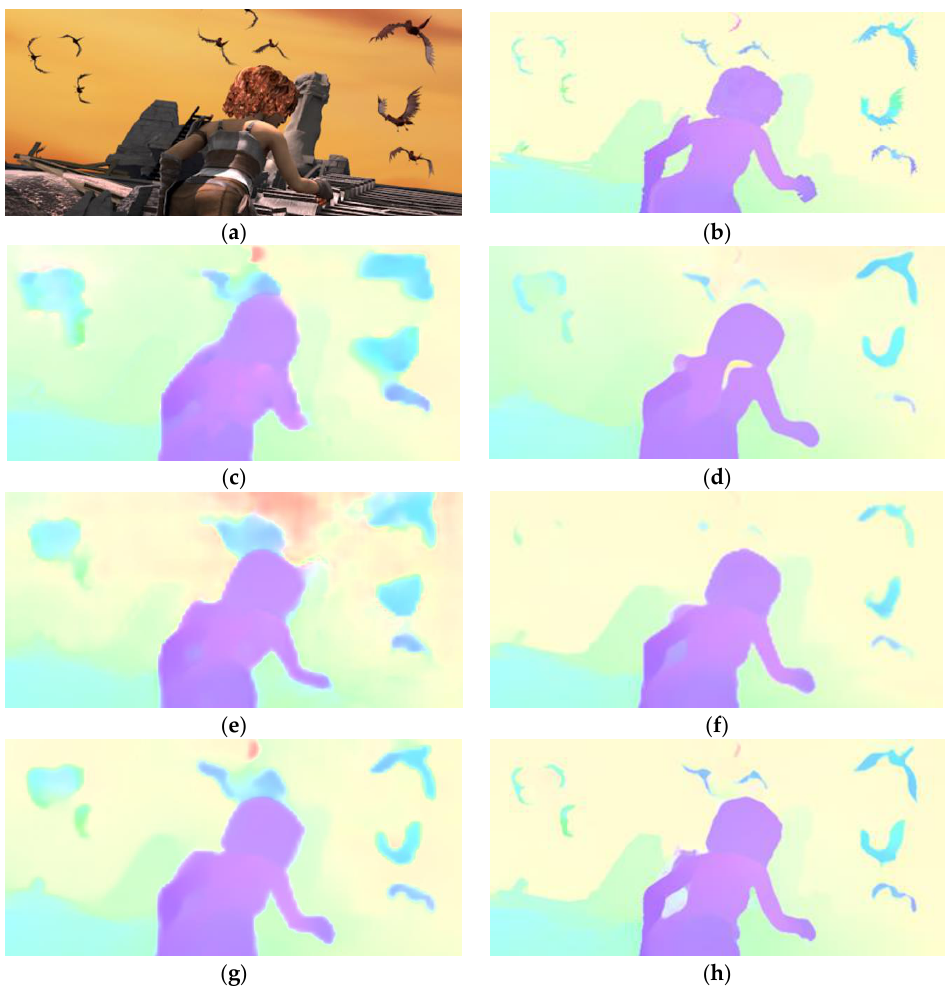
Figure 18. Visual comparison of optical flow fields estimated by different motion estimators: ( a ) Temple1; ( b ) ground truth; ( c ) ARFlow [25]; ( d ) FlowNet2 [22]; ( e ) PWC-Net [23]; ( f ) MaskFlownet [47]; ( g ) LiteFlowNet3 [48]; ( h ) DCN-Flow.